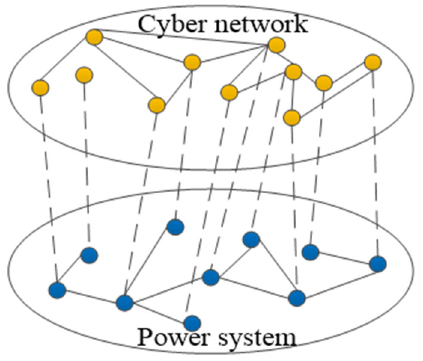
Figure 3. Double-layer network of the cyber-physical power system.